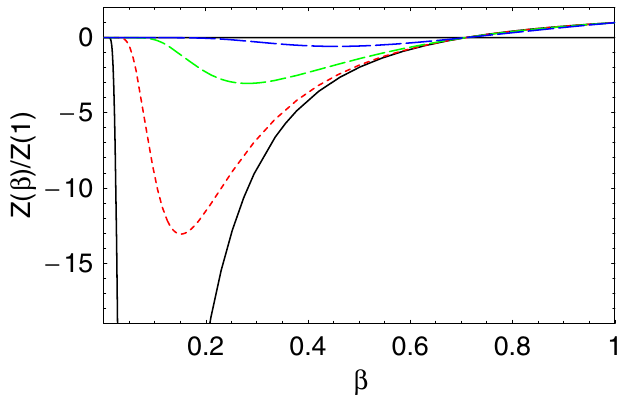
FIG. 1. (Color) The ratio of the longitudinal impedance (29) to its relativistic value for a circular hole in a round pipe versus (cid:2) (cid:5) v=c for !b=c (cid:5) 0 : 1 ; 0 : 25 ; 0 : 5 ; 1 (solid, short-dashed, dashed, and long-dashed curves).